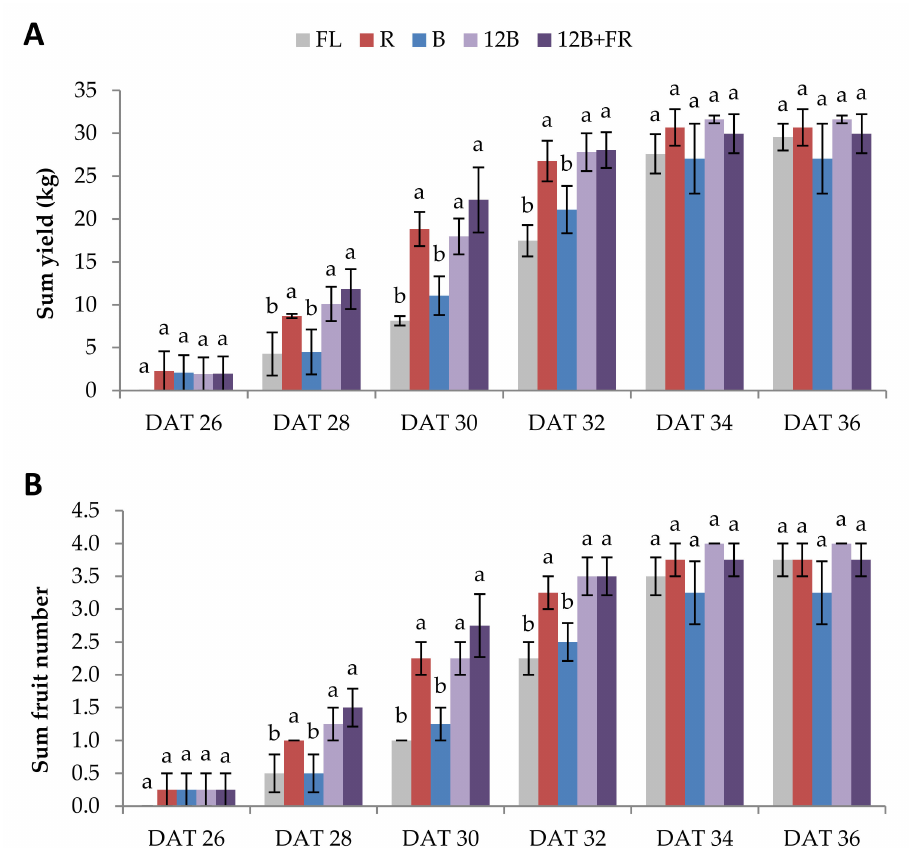
Figure 3. ( A ) Sum of watermelon fruit yield and ( B ) sum of fruit number derived from flowers bloomed from the 26th to the 36th day after transplanting in the field. The seedlings were treated for six days in a healing chamber with five light treatments. Mean values ( n = 4; ± SE) within a row followed by different letters are significantly different ( α < 0.05).